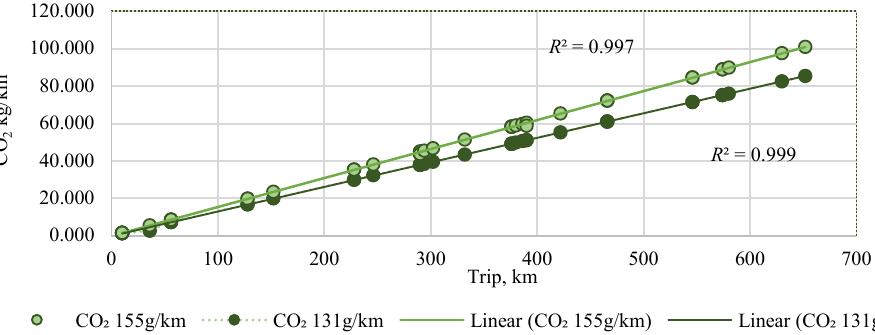
Fig. 5. Relationship between CO 2 emissions and travel distance if emissions are CO 2 131 g/km and CO 2 155